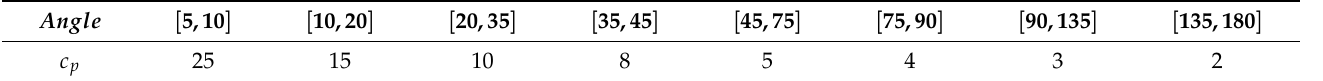
Table 4. The maximum number of rotations corresponding to different angles of rotation in each cycle of CMG.